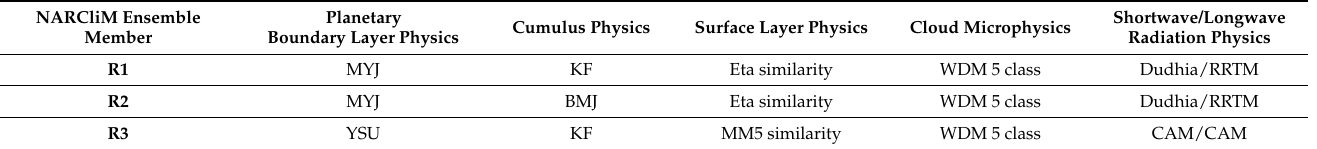
Table A1. The model configuration for the three independent RCMs. Here, the planetary boundary layer schemes include the Yonsei University (YSU) and the Mellor-Yamada-Janjic (MYJ) schemes. The cumulus physics schemes include the Kain-Fritsch (KF) and the Betts-Miller-Janiac (BMJ) parame- terization. The radiation schemes include the Dudhia shortwave scheme, Rapid Radiative Transfer Model (RRTM) longwave scheme and the Community Atmospheric Model (CAM) radiation scheme. The cloud microphysics applies the double-moment five-class (WDM5) scheme.